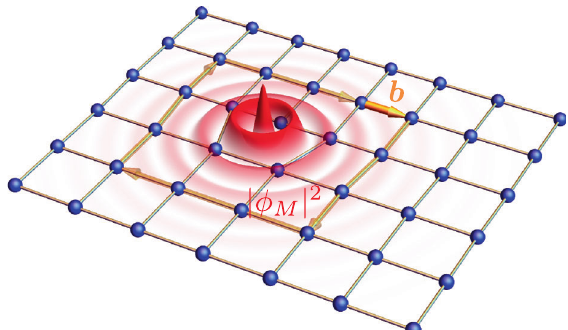
Fig. 3 If the superconducting state in thin layers of Sr 2 RuO 4 is fully gapped, a Kramers pair of Majorana modes ( red ) will be localized at dislocations charactered by a Burgers vector b ( orange ) with b 1 + b 2